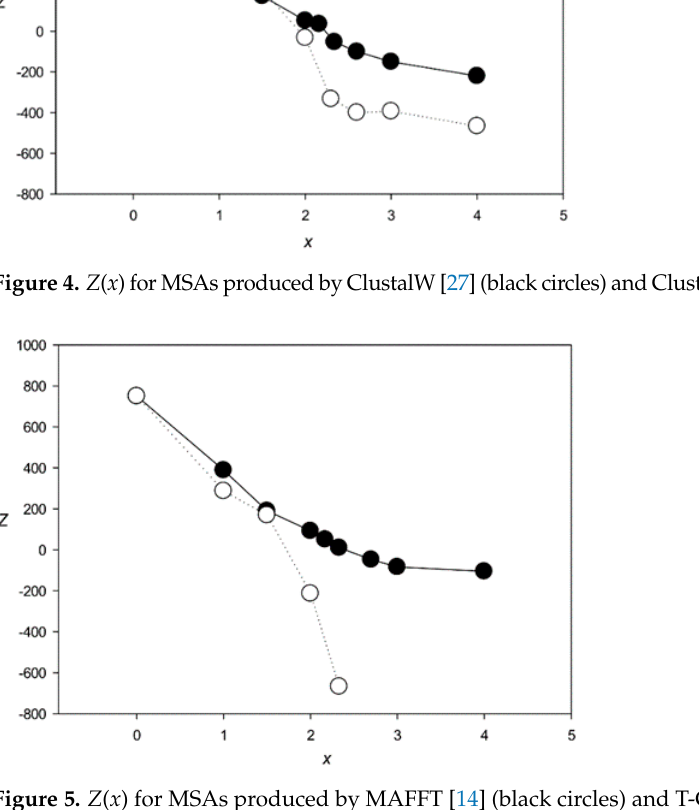
Figure 5. Z ( x ) for MSAs produced by MAFFT [14] (black circles) and T-Coffee [17] (white circles).